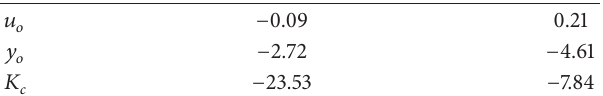
Table 1: Operating points for 2 segments.